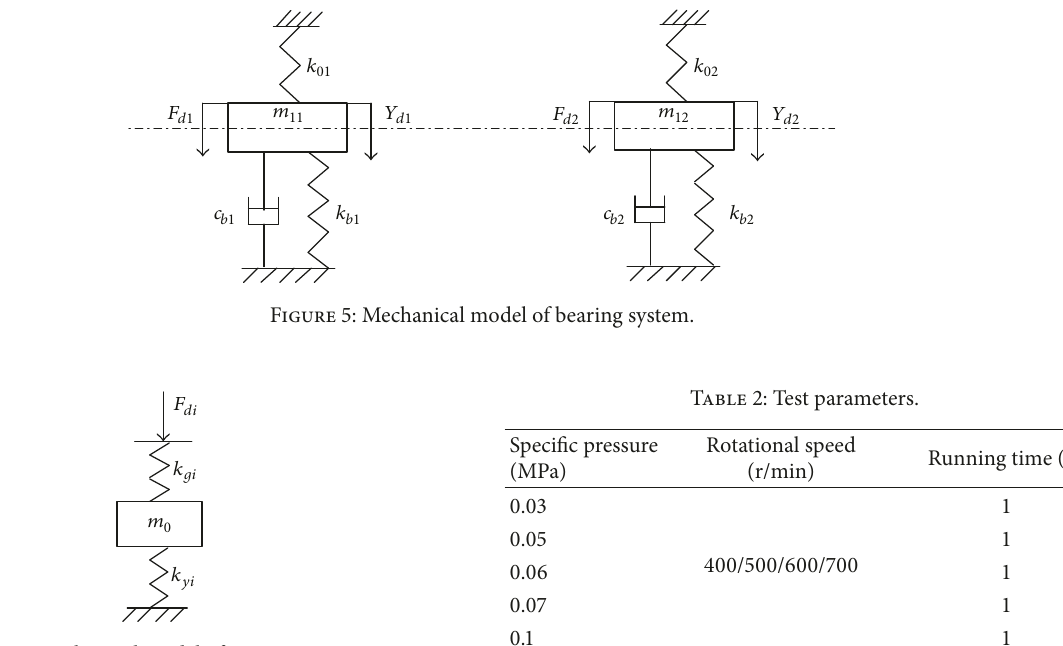
Figure 6: Mechanical model of connection part.